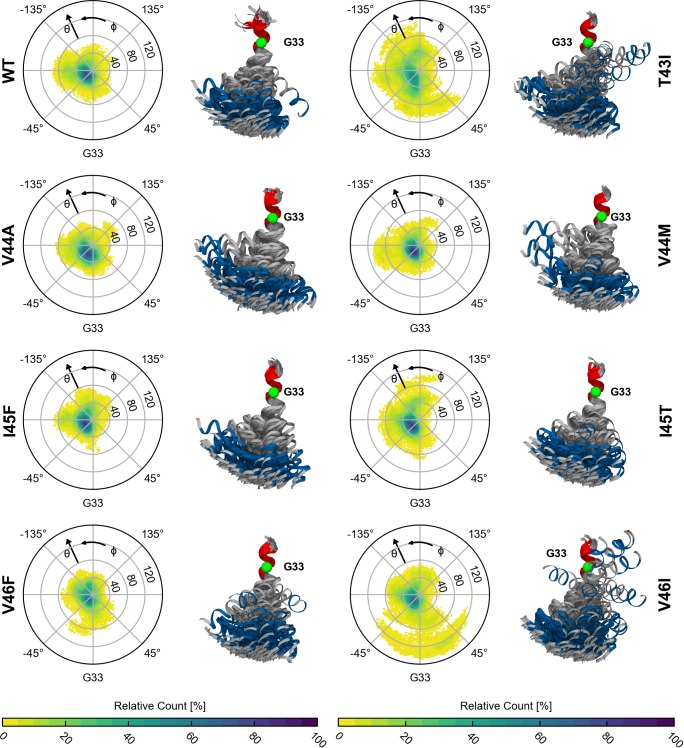
Cleavage domain orientation.Polar plots show 2D histograms of bending (θ) and swivel (Φ) angles characterizing the orientation of the helix segment I47-M51 carrying the ε-sites with respect to segment A30-L34. All values binned with a width of 2° were normalized to the bin with the overall highest count for all TMDs. Structures show an overlay of 150 frames with 1 ns spacing, visualizing the extent of shape fluctuations. Domains coloured in blue and red represent the selected reference segments for computation of angles. Green spheres represent Cα atoms of G33. The axis of the helical segment drawn in red has been aligned to the z-axis of the coordinate system and rotated around this axis to align the Cα atom of G33 with the x-axis.